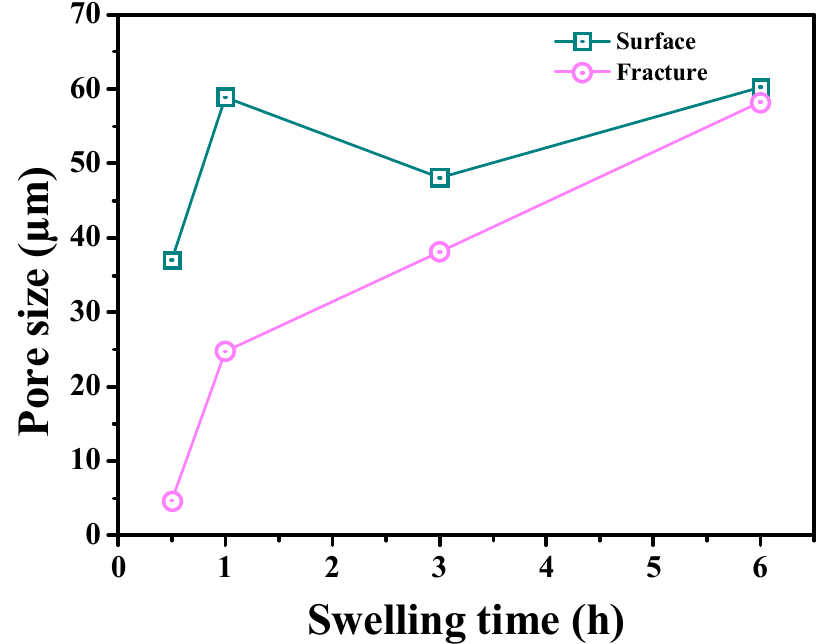
Figure 9. Effects of swelling time on pore size for PS14-PEG hydrogel.